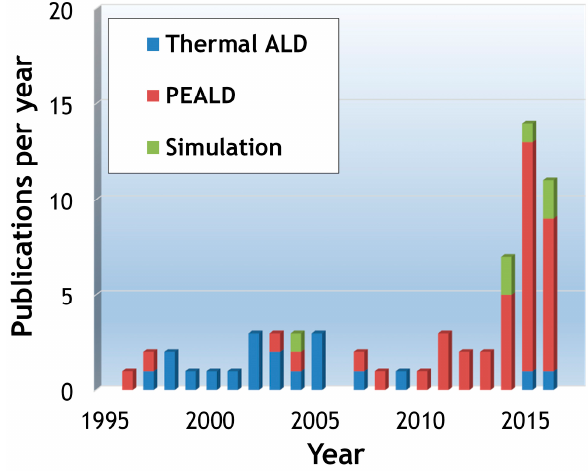
Figure 1. Number of publications per year with respect to atomic layer deposition (ALD) of silicon nitride (SiN x ) since the first report by Goto et al. was available in 1996 [16], as retrieved in the Web of Science and Google Scholar (through 31 July 2016). The key words for searching included the combination of “atomic layer deposition/atomic layer CVD/plasma-enhanced ALD/plasma-assisted ALD/ALD/PEALD” and “silicon nitride/Si nitride/Si 3 N 4 /SiN/SiN x ”. Irrelevant publications were not considered.